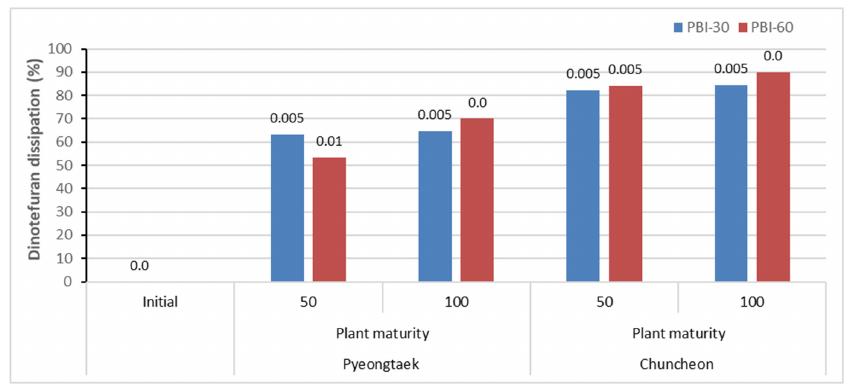
Figure 1. Dinotefuran dissipation (%) in lettuce soil of Pyeontaek and Chuncheon fields. Figure legend: values above the columns—standard error; PBI-30—30-day plant back intervals; PBI-60—60-day plant back intervals. Sample size: 4 samples.